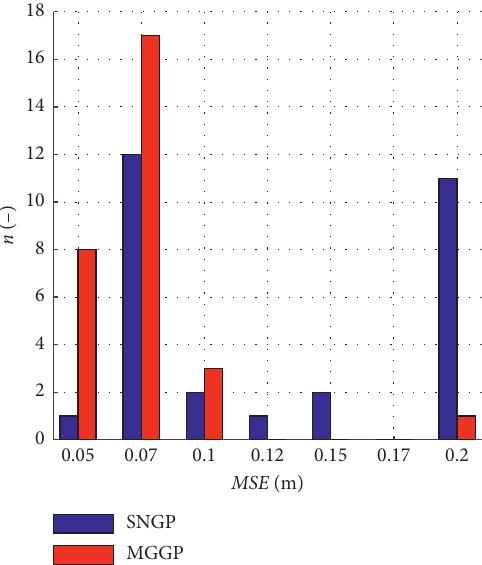
Figure 10: Histogram dividing the tested models into several categories according to their